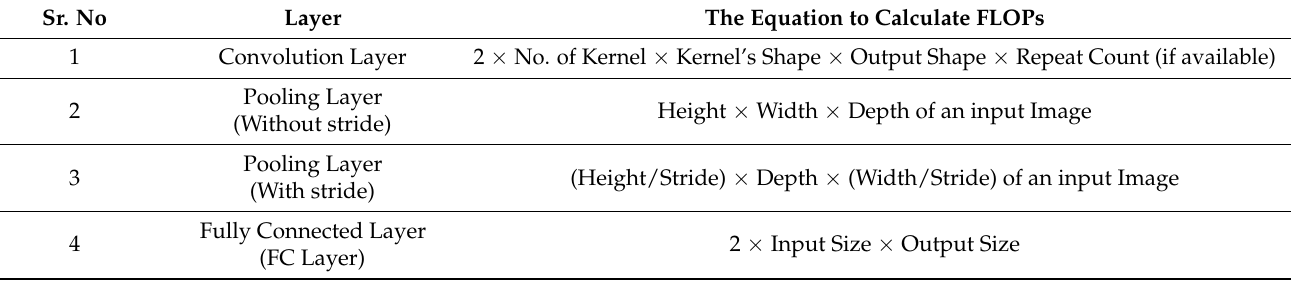
Table 2. Equations to calculate FLOPs of each CNN layer.